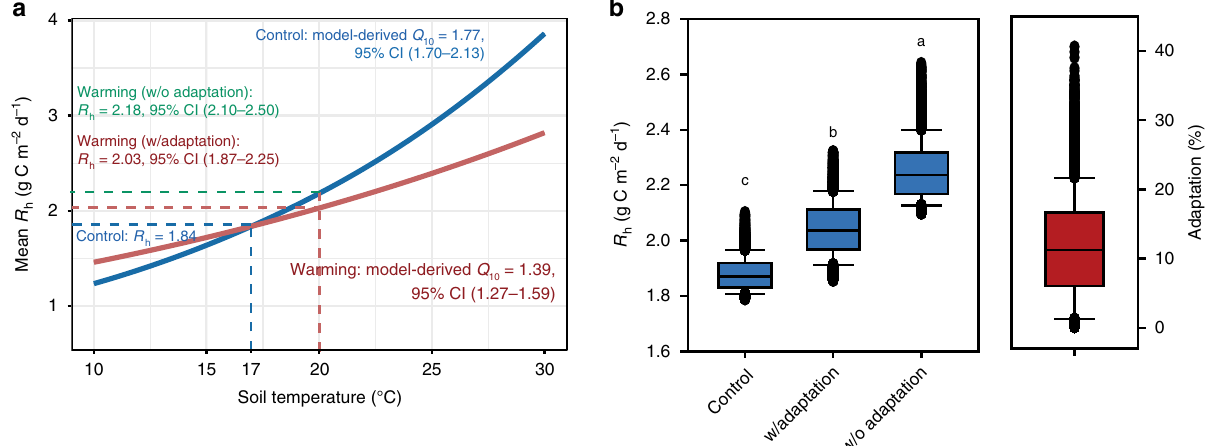
Fig. 4 Microbial thermal adaptation of heterotrophic respiration ( R h ) based on model-derived Q 10 . a Demonstration of R h thermal adaptation based on the mean Q 10 values. The mean annual soil temperature ( T ) during 2010 – 2016 was 17 °C and 20 °C under control and warming, respectively. The average model-derived Q 10 = 1.77 under control and 1.39 under warming. The mean baseline R h = 1.84 g C m – 2 d – 1 under control ( T = 17 °C). The average R h = 2.03 and 2.18 g C m – 2 d – 1 under warming ( T = 20 °C) when thermal adaptation is considered (w/ Adaptation) or not considered (w/o Adaptation). The % Δ R h = 8.2% means a 8.2% reduction in R h relative to the baseline R h = 1.84 g C m – 2 d – 1 under control. 95% CI denotes the 95% con fi dence interval. b Thermal adaptation in R h when the uncertainties in model-derived Q 10 are considered. The mean thermal adaption (% Δ R h ) is 11.6%, which is different from the speci fi c % Δ R h = 8.2% derived from mean Q 10 values. However, both of these % Δ R h values are within the uncertainty range of % Δ R h . Different letters for R h indicate signi fi cantly differences between the scenarios based on the Kruskal – Wallis test at a signi fi cance level of 0.05. The thermal adaptation (%) is quanti fi ed by the difference in R h between warming w/o Adaptation and w/ Adaptation as a percentage of the baseline R h under control (see “ Methods ” Eq. It should be noted that the model-derived Q 10 values may not represent the true intrinsic temperature sensitivity of microbial and enzyme activities. In this study, the MEND-derived Q 10 values were con fi ned from 1.20 to 2.42 (tMEND) to a narrow range of 1.27 – 2.13 (gMEND), corroborating that Q 10 values of 2 or below are usually used in global C cycle modeling 29,38 . The MEND-derived Q 10 values (1.77 ± 0.12 for control, and 1.39 ± 0.09 for warming) were close to those estimated from the TECO model in the current study (1.79 ± 0.09 for control, and 1.50 ± 0.15 for warming), as well as a previous study with the TECO model (1.4 – 2.5) 37 . Our model-derived Q 10 under warming was similar to the detrended temperature sensitivity (1.4 ± 0.1)